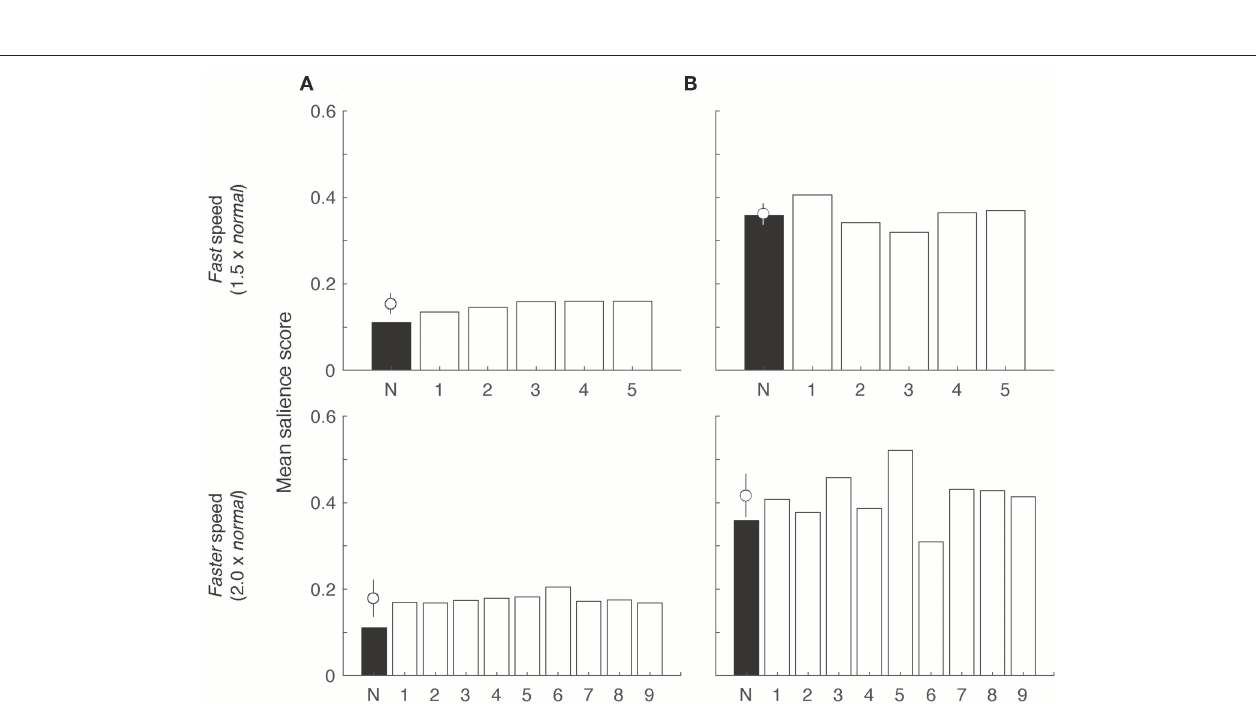
FIGURE 9 | The salience scores of the tail flick component were lower than that of the rest of the display, but the rest of the display showed greater variability in response to background conditions. Bar charts show mean salience score of (A) tail flicks and (B) the rest of the display. Data are shown for the sequence at normal speed ( N ) and the set of animations at 1.5 × (top row) and 2.0 × (bottom row) normal speed. In each plot, the normal speed sequence ( N ) is shown in black, with the open circle representing the mean ( ± SE) of the faster speed sequences to the right.